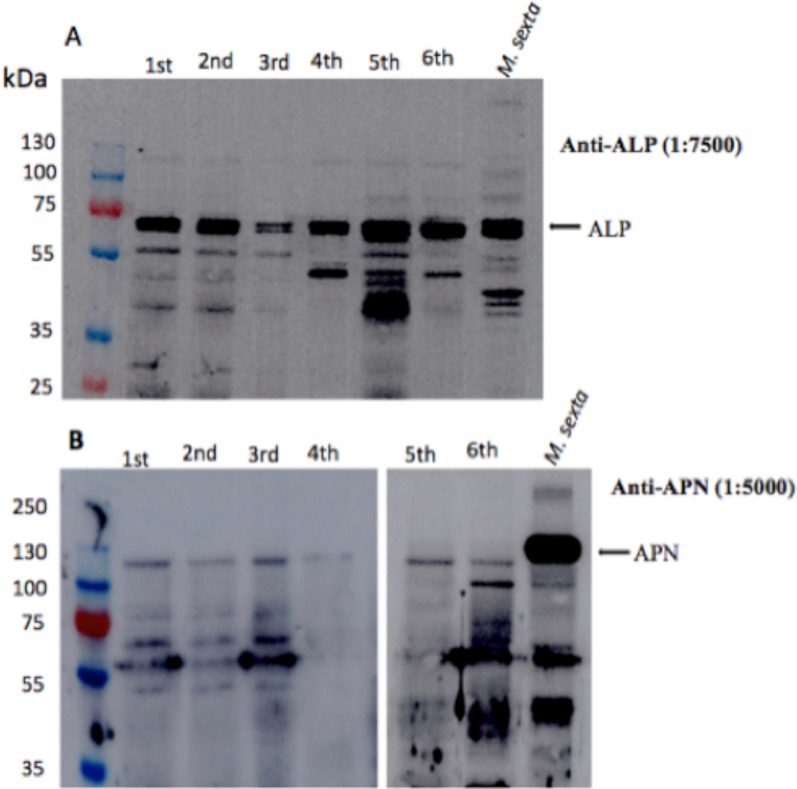
Immunodetection of ALP and APN proteins in BBMV preparations form the different instar of H. armigera.Panel A, detection of ALP protein by western blot assays using anti-ALP antibody that was raised against the ALP protein from M. sexta. Panel B, detection of APN protein by western blot assays using anti-APN antibody that was raised against the APN protein from M. sexta. The different lanes were loaded with the same concentration of protein (10 μg BBMV protein). S1 Fig shows the SDS-PAGE image of the loaded proteins stained with Coomassie Blue. Positive control was BBMV from M. sexta.